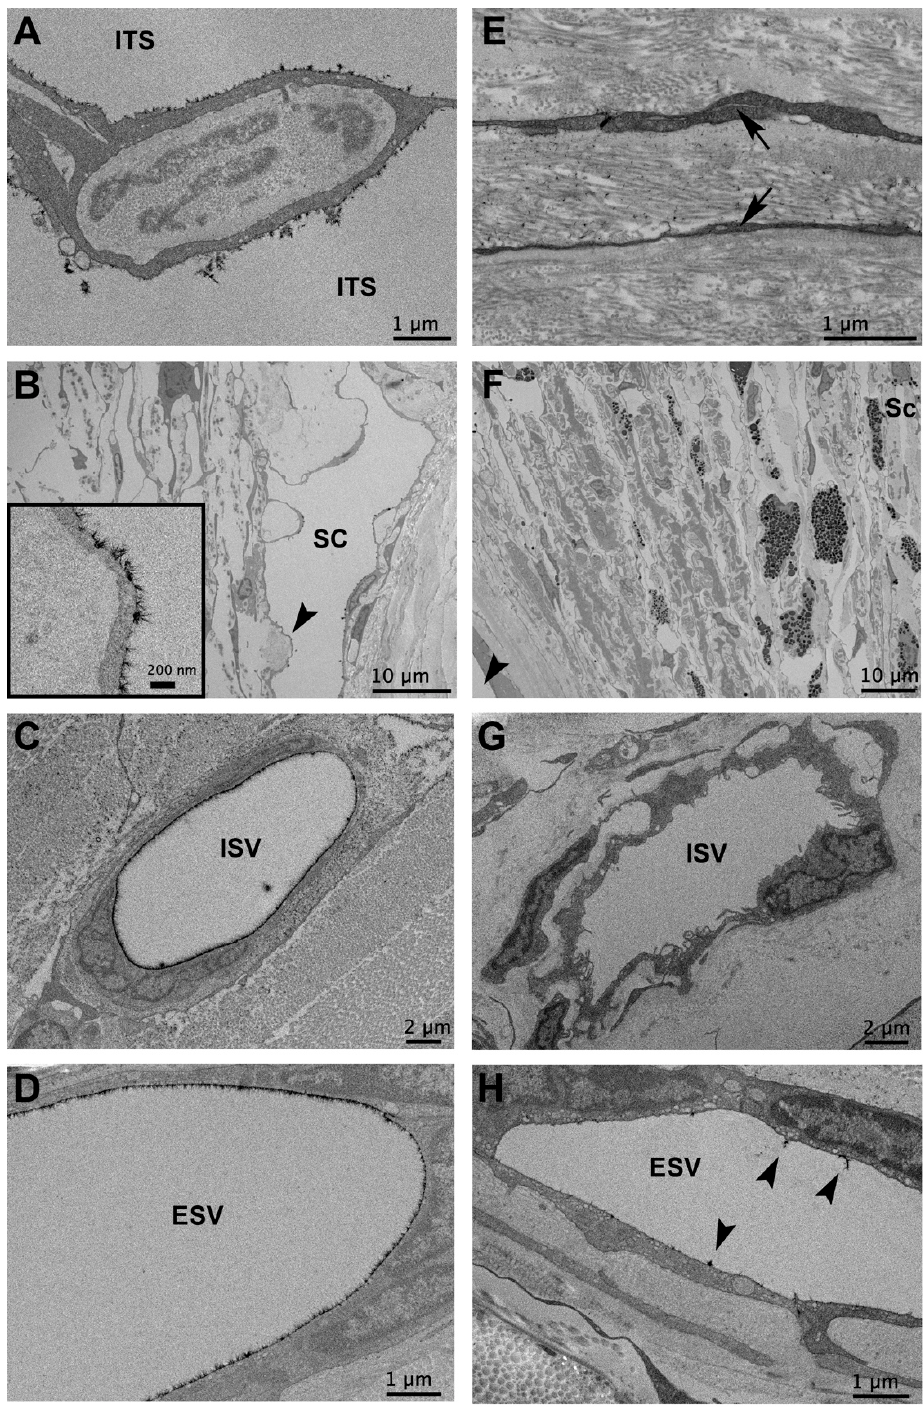
Figure 2. Differences in morphology and glycocalyx coverage in control and laser-treated outflow pathway locations. In control eyes, trabecular beams were separated by notable intertrabecular spaces (ITSs; ( A )), Schlemm’s canal (SC) was patent ( B ) with glycocalyx coverage, (arrowhead indicates region shown at high magnification in inset image), and both intrascleral veins (ISVs; ( C )) and episcleral veins (ESVs; ( D )) displayed significant glycocalyx coverage. In contrast, in laser-treated regions, ITSs were collapsed (arrows; ( E )), and SC was partially to completely obliterated ( F ). The arrowhead in ( F ) indicates the anterior chamber. In addition, ISVs ( G ) and ESVs ( H ) in laser-treated regions displayed minimal to absent glycocalyx. The arrowheads in ( H ) indicate small clusters of the glycocalyx in an ESV. Sc: